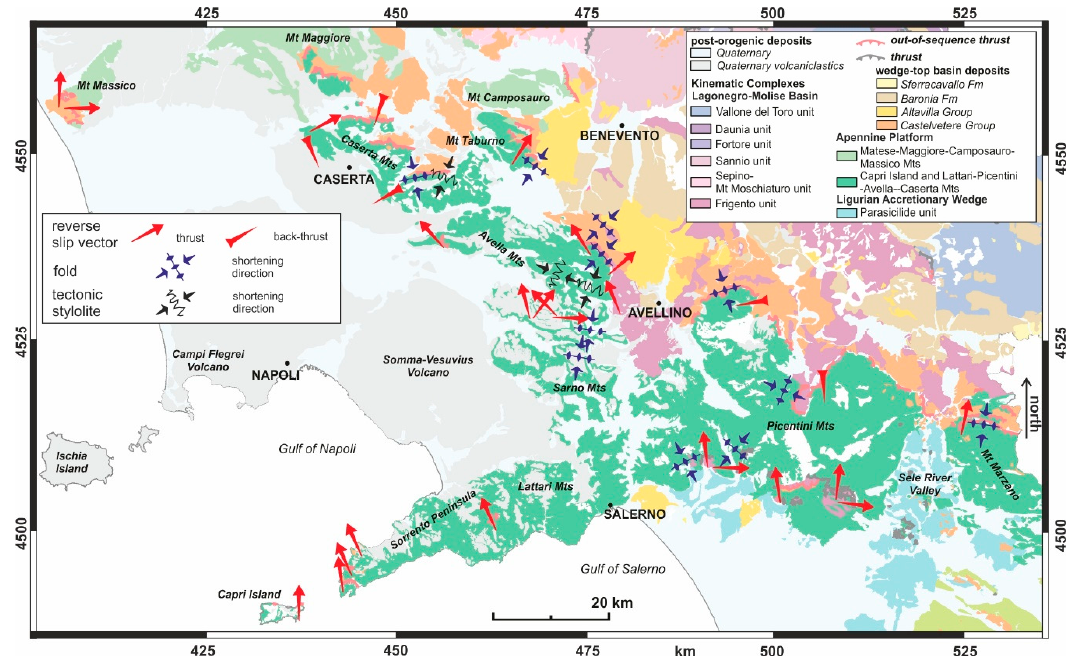
Figure 11. Tectonic map of the study area showing tectonic vergences and shortening directions for the studied out-of-sequence deformation structures.